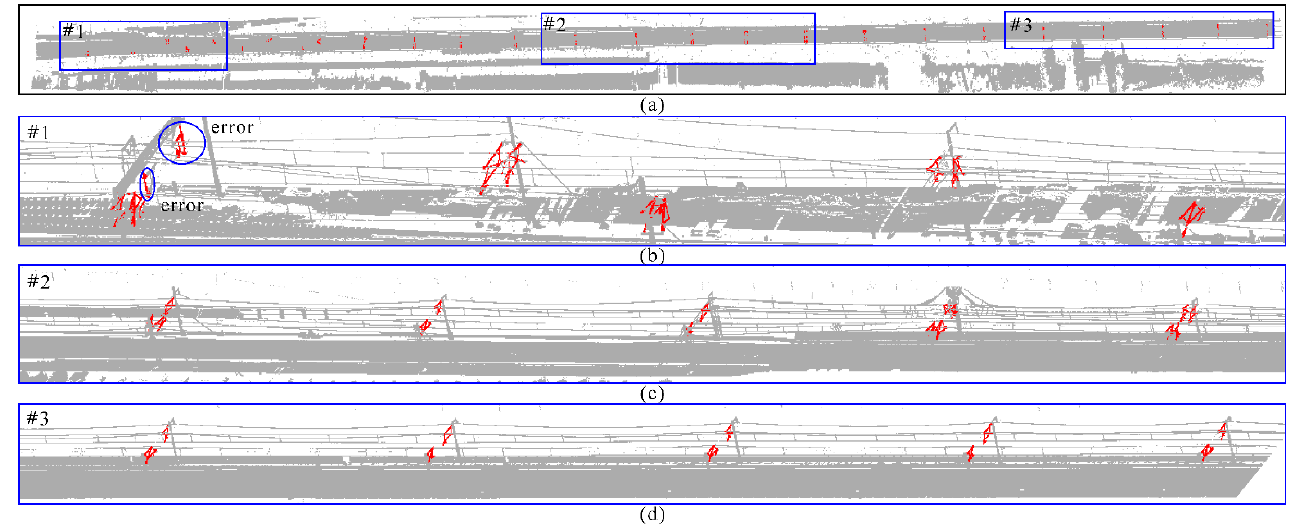
Figure 9. Applied experiment test results of unit 1. Specifically, ( a ) shows the test results, ( b ) shows close-up views of region #1, ( c ) shows close-up views of region #2, and ( d ) shows close-up views of region #3.